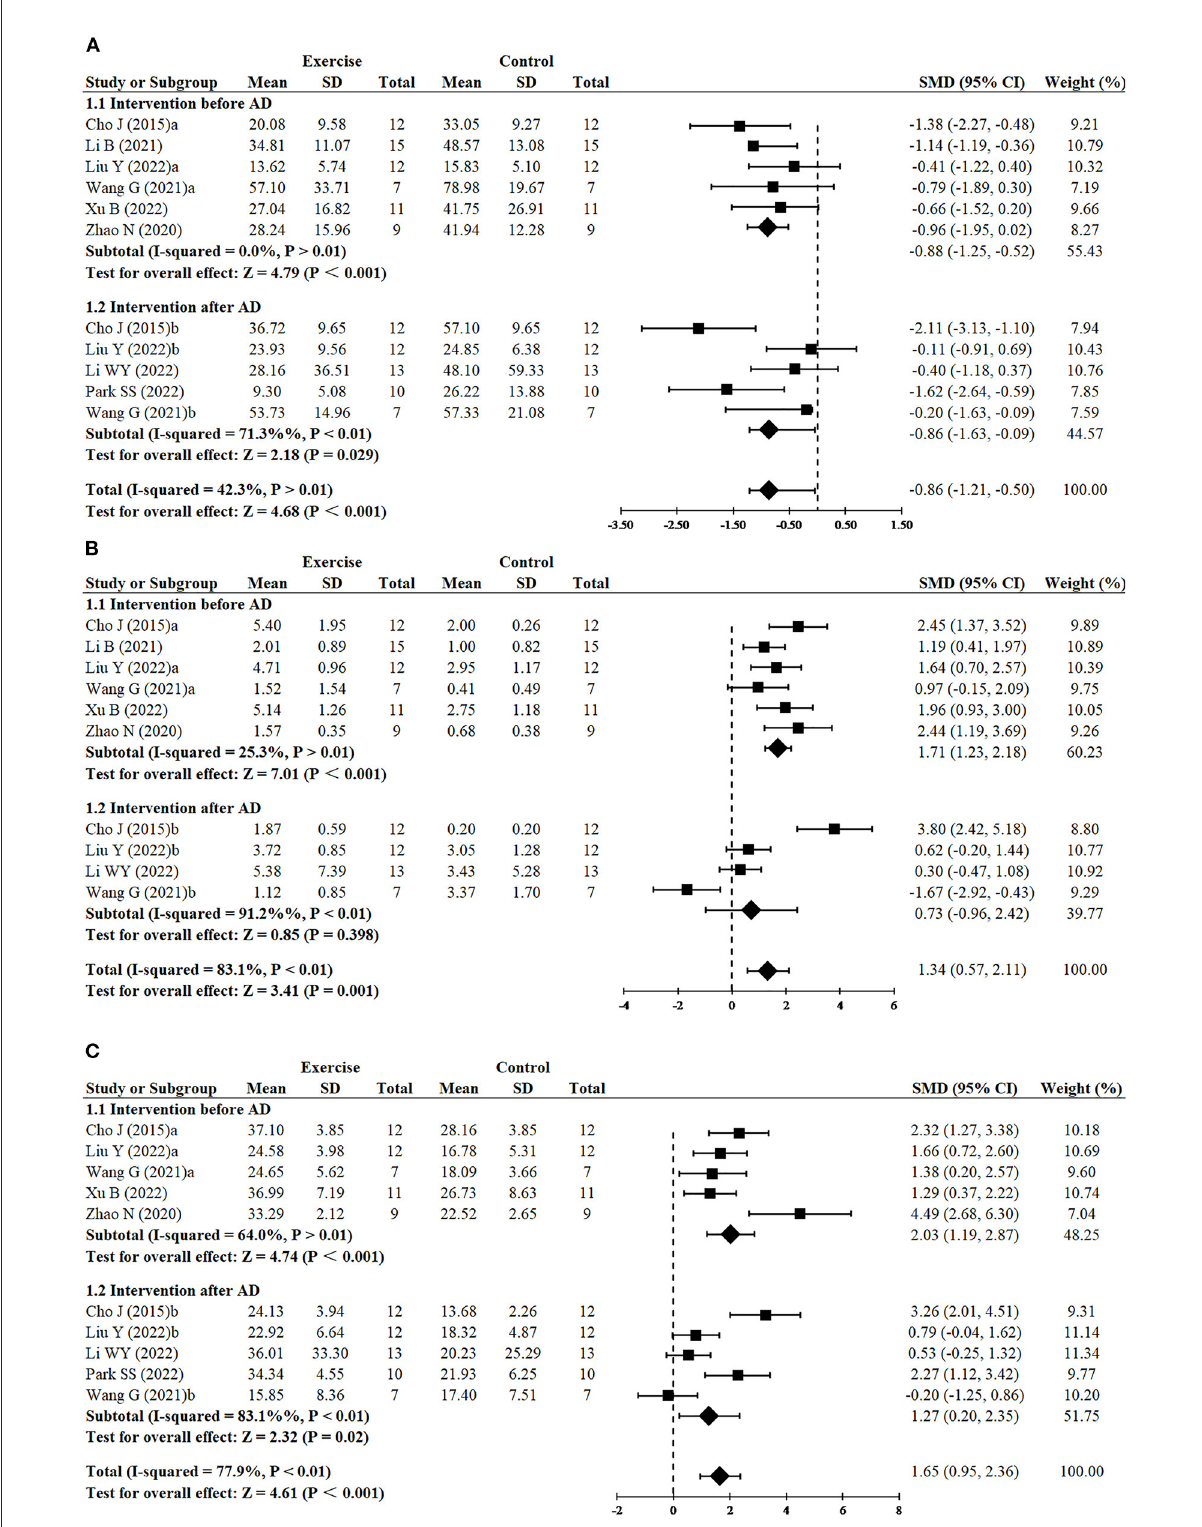
FIGURE2 Forest plots showing the effect of exercise on cognitive function in AD models. (A) The effect of exercise on the escape latency of MWM. (B) The effect of exercise on the number of platform crossings of MWM. (C) The effect of exercise on the time in the target quadrant of